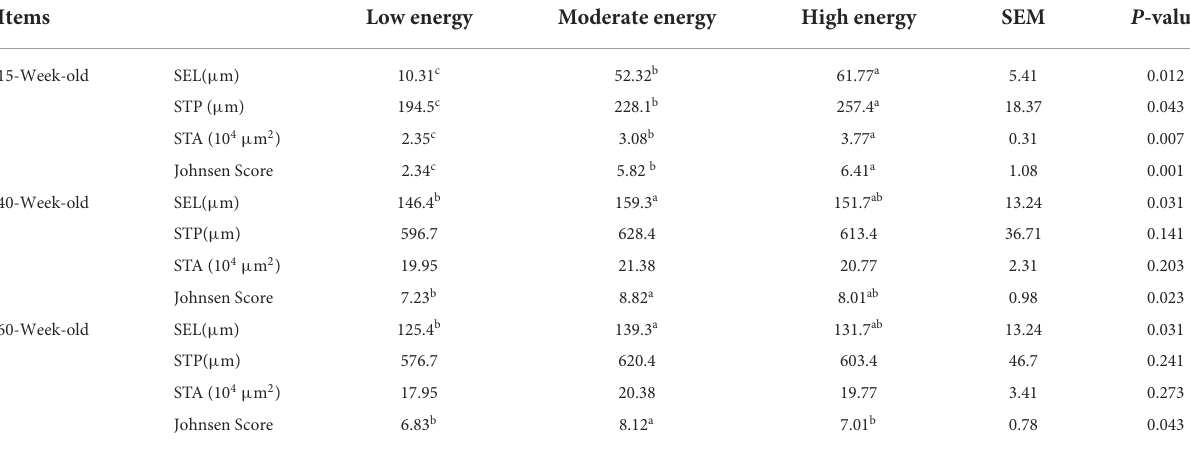
TABLE 5 Effects of different energy levels on morphometric development of testis and seminiferous